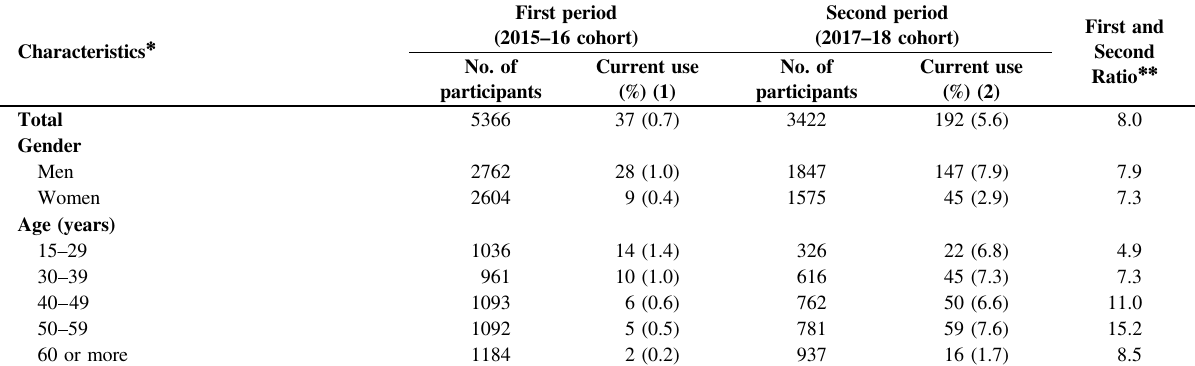
Table 1 Prevalence of current use of heated tobacco products by characteristics, fi rst and second survey period